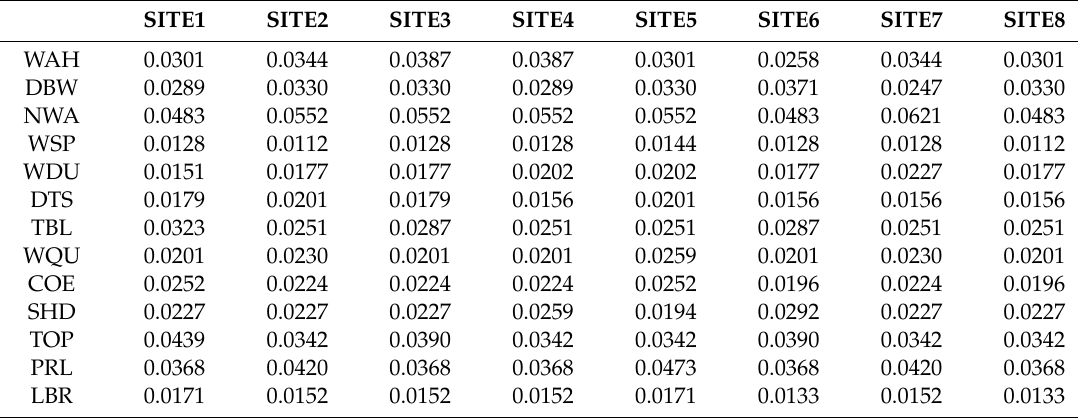
Table 8. Normalized weight